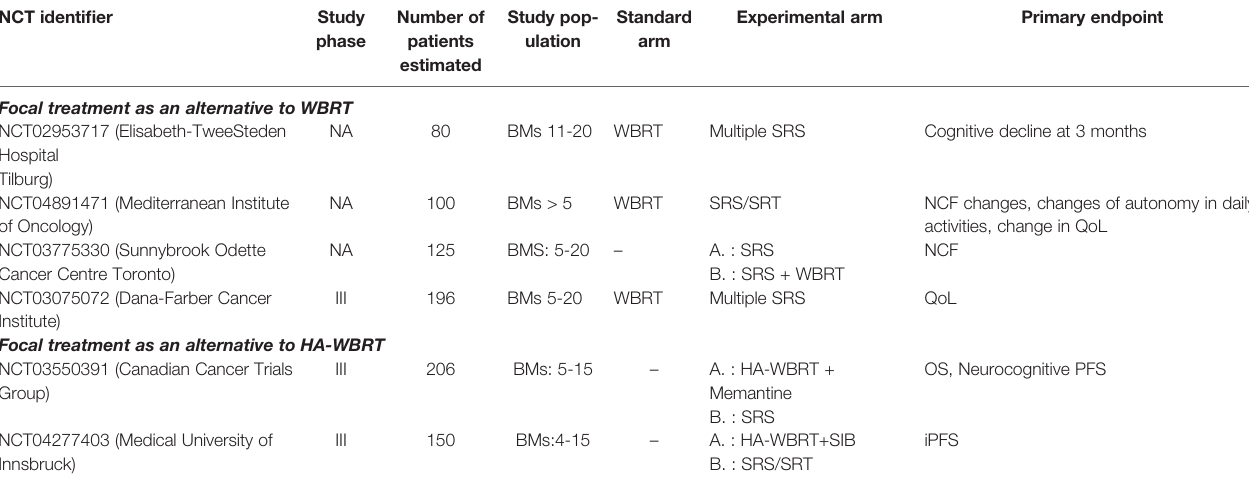
TABLE 3 | Currently ongoing clinical trials investigating SRS/SRT for multiple